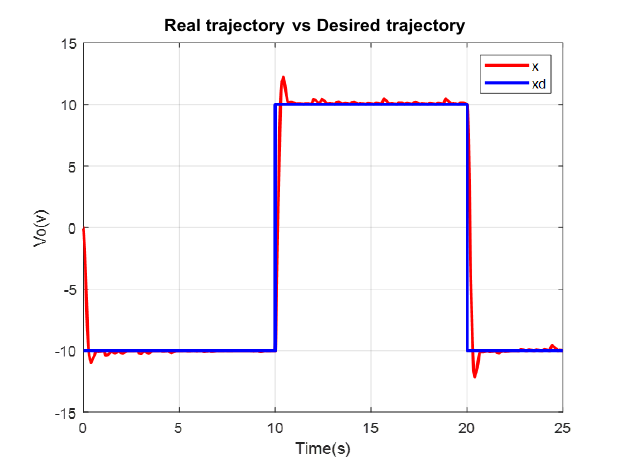
Figure 8. Self tuning control: real versus desired trajectory (position change).